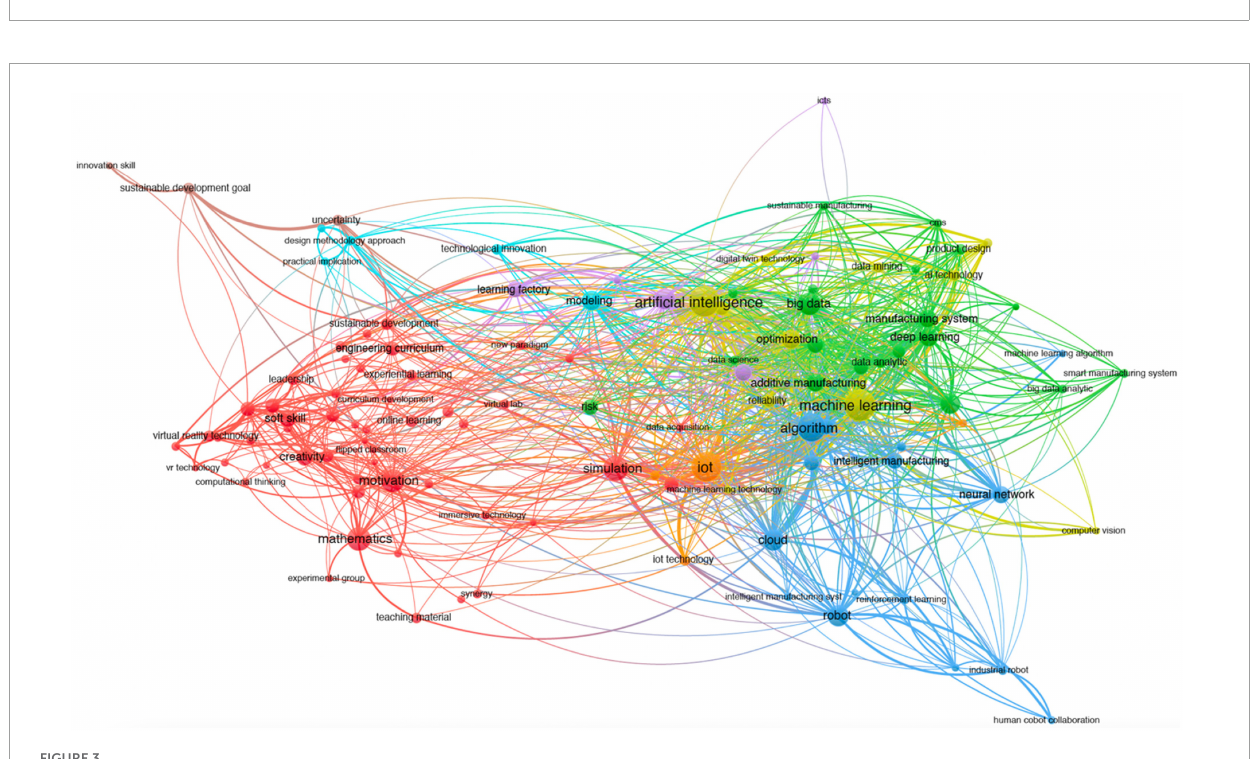
is a stark difference, compared to previous works in the literature,